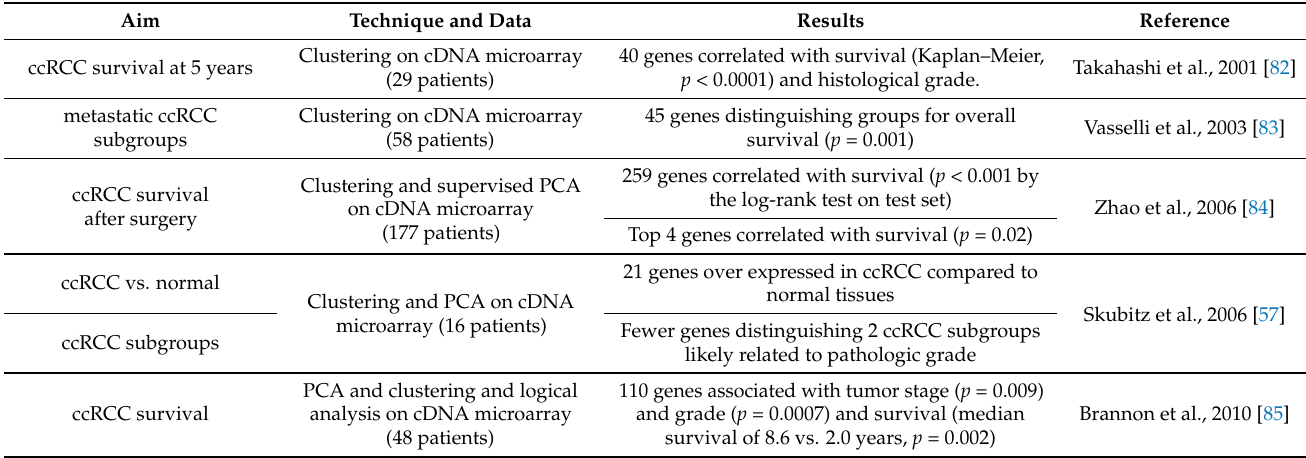
Table 2. The table collects the studies that used different techniques than machine learning to predict diagnosis and